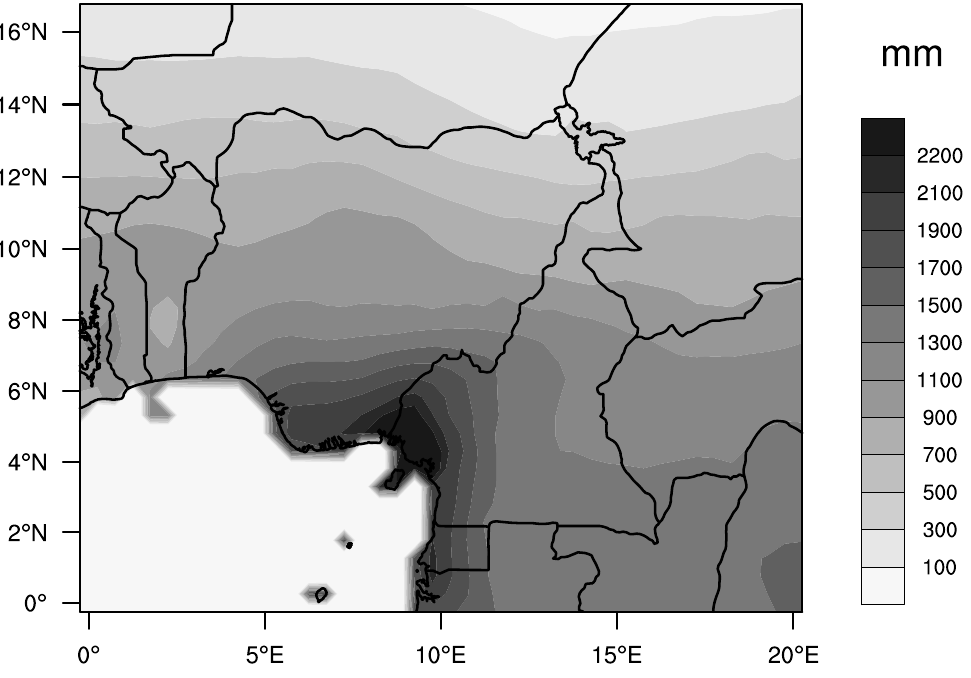
Figure 2. Spatial pattern of Climate Research Unit (CRU) TS 3.1 mean annual cumulative rainfall for a period of 50 year (1953–2002). Isohyetal lines are labeled in millimeters per